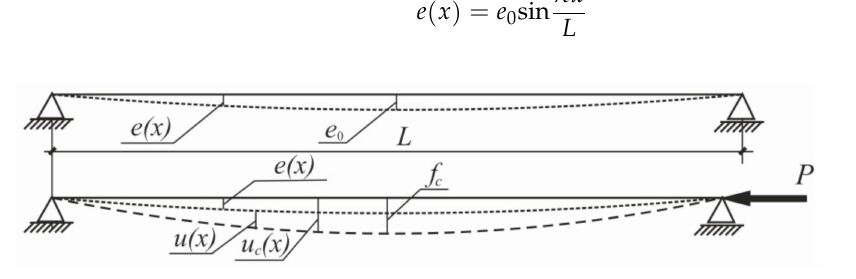
Figure 9. Deflections of the initially curved